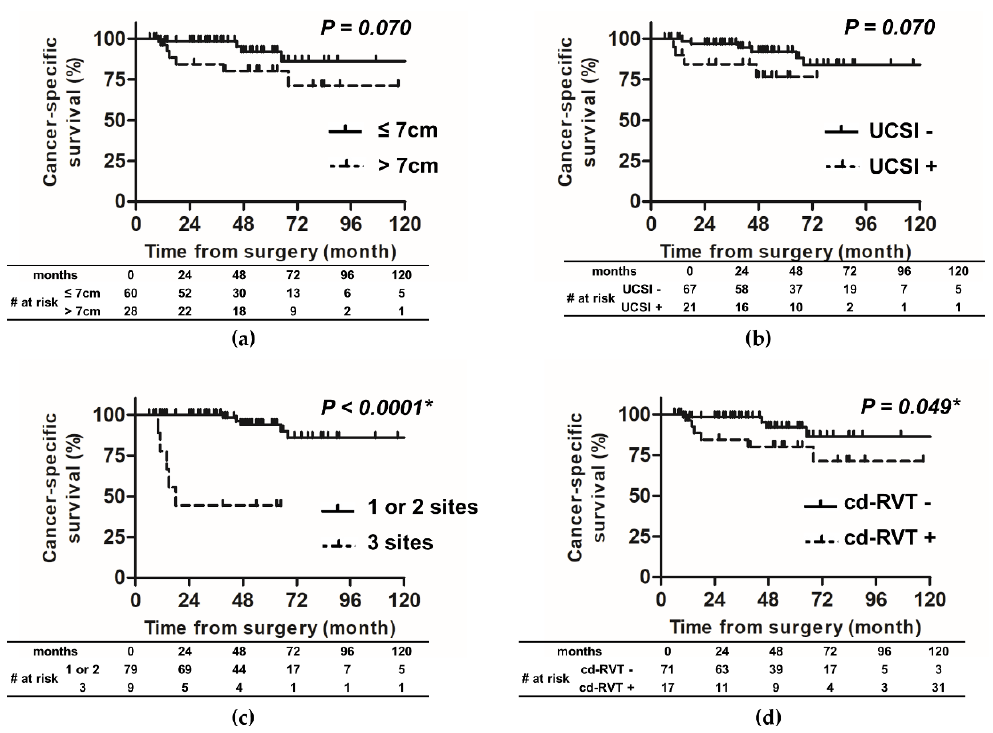
Figure 4. Cancer ‐ specific survival probabilities for four main factors: tumor size, urinary Figure 4. Cancer-specific survival probabilities for four main factors: tumor size, urinary collecting system invasion, pathological invasion sites, and clinically detected renal vein thrombus. Patients